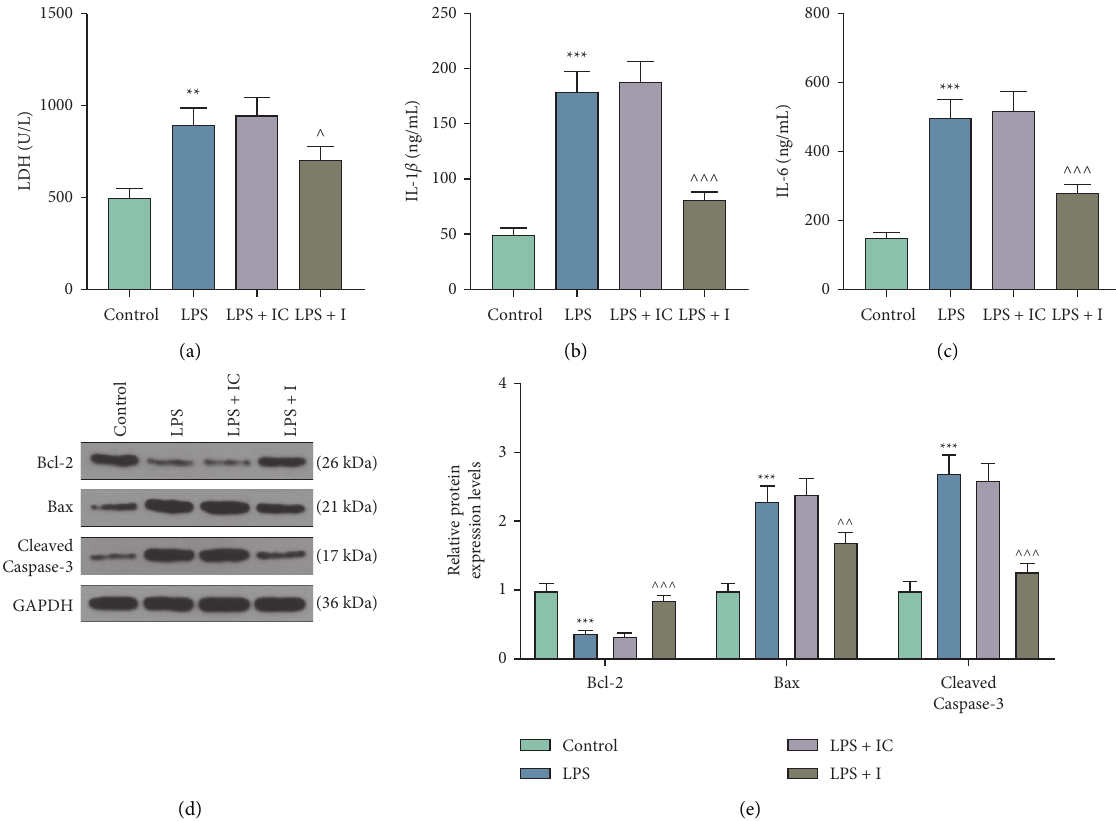
Figure 2: The downregulation of miR-197 suppressed the LPS-induced inflammation injury in H9C2 cells. (a) The LDH assay kit was applied to measure the level of LDH in LPS-induced H9c2 cells transfected with or without the miR-197 inhibitor. (b, c) ELISA was conducted to evaluate the proinflammatory factors, IL-1 β and IL-6. (d, e) The protein levels of apoptosis-related genes (Bcl-2, Bax, and cleaved caspase-3) were tested using western blot. GAPDH was used as the loading control. The experiments were repeated three times. ∗∗ p < 0 . 01; ∗∗∗ p < 0 . 001 vs. control; ∧ p < 0 . 05; ∧∧ p < 0 . 01; ∧∧∧ p < 0 . 001 vs. LPS+IC. LDH, lactate dehydrogenase; ELISA, enzyme-linked immunosorbent assay; LPS, lipopolysaccharide; IL-1 β , interleukin-1 β ; IL-6, interleukin-6; Bcl-2, B-cell lymphoma-2; Bax, BCL2-associated X; GAPDH, glyceraldehyde-3-phosphate dehydrogenase; I, miR-197 inhibitor; IC, inhibitor